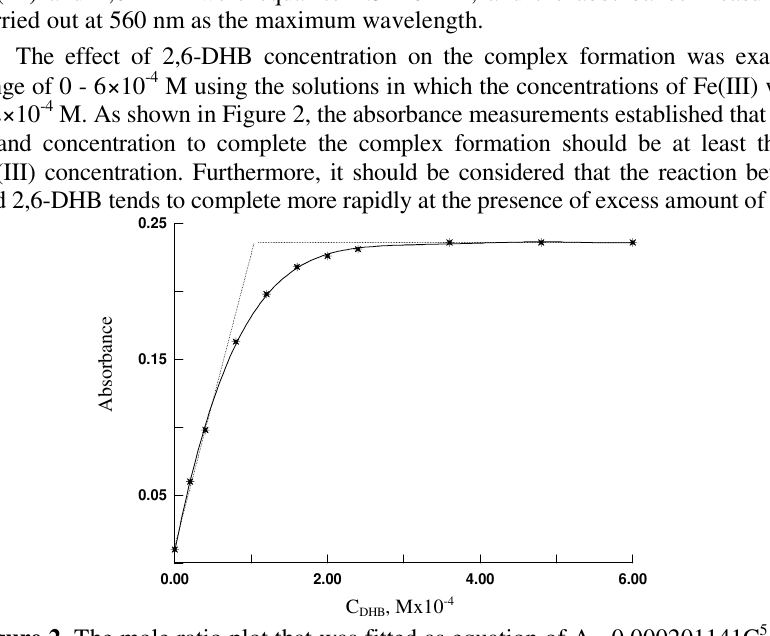
Figure 2 . The mole ratio plot that was fitted as equation of A= 0.000201141C 5 -0.00423842 C 4 +0.0349676 C 3 -0.141571 C 2 +0.283276C +0: 0.00874717, (r 2 : 0.999635). The extrapolated Equations: A = 0.215002 C + 0.012333; A = 7.28825×10 -018 C + 0.236.